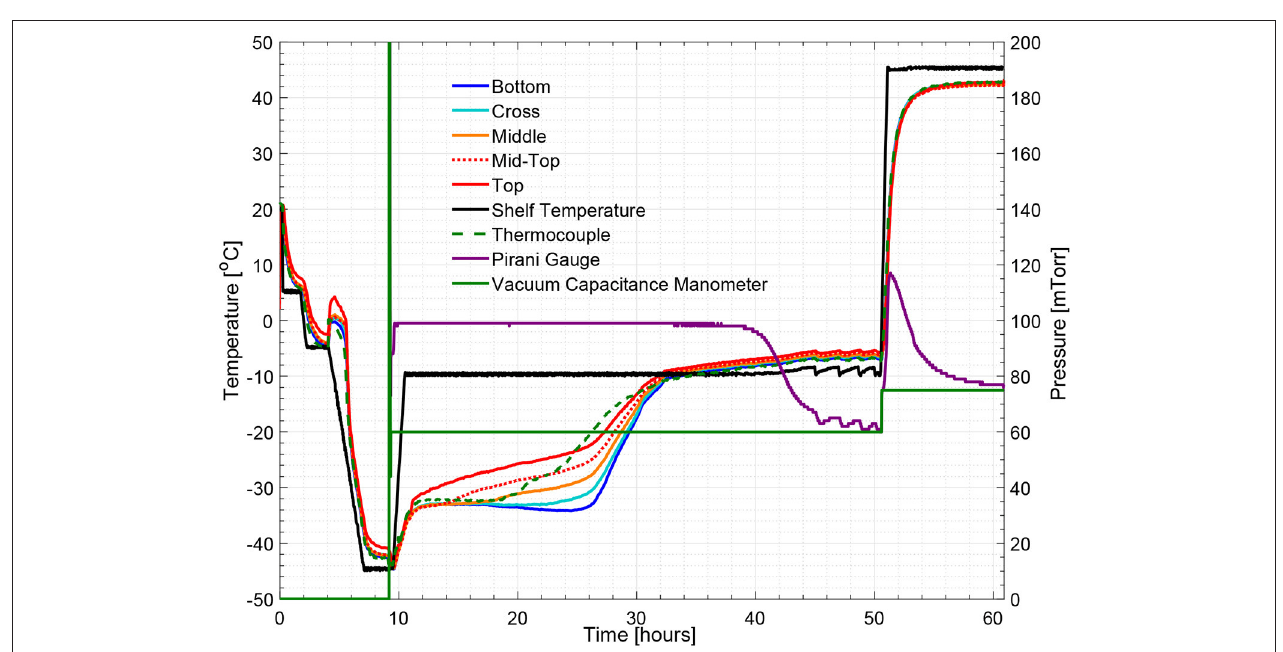
FIGURE 8 | Measured temperature and pressure over time profile of 5% w/v sucrose solution for an edge vial (cycle 2).